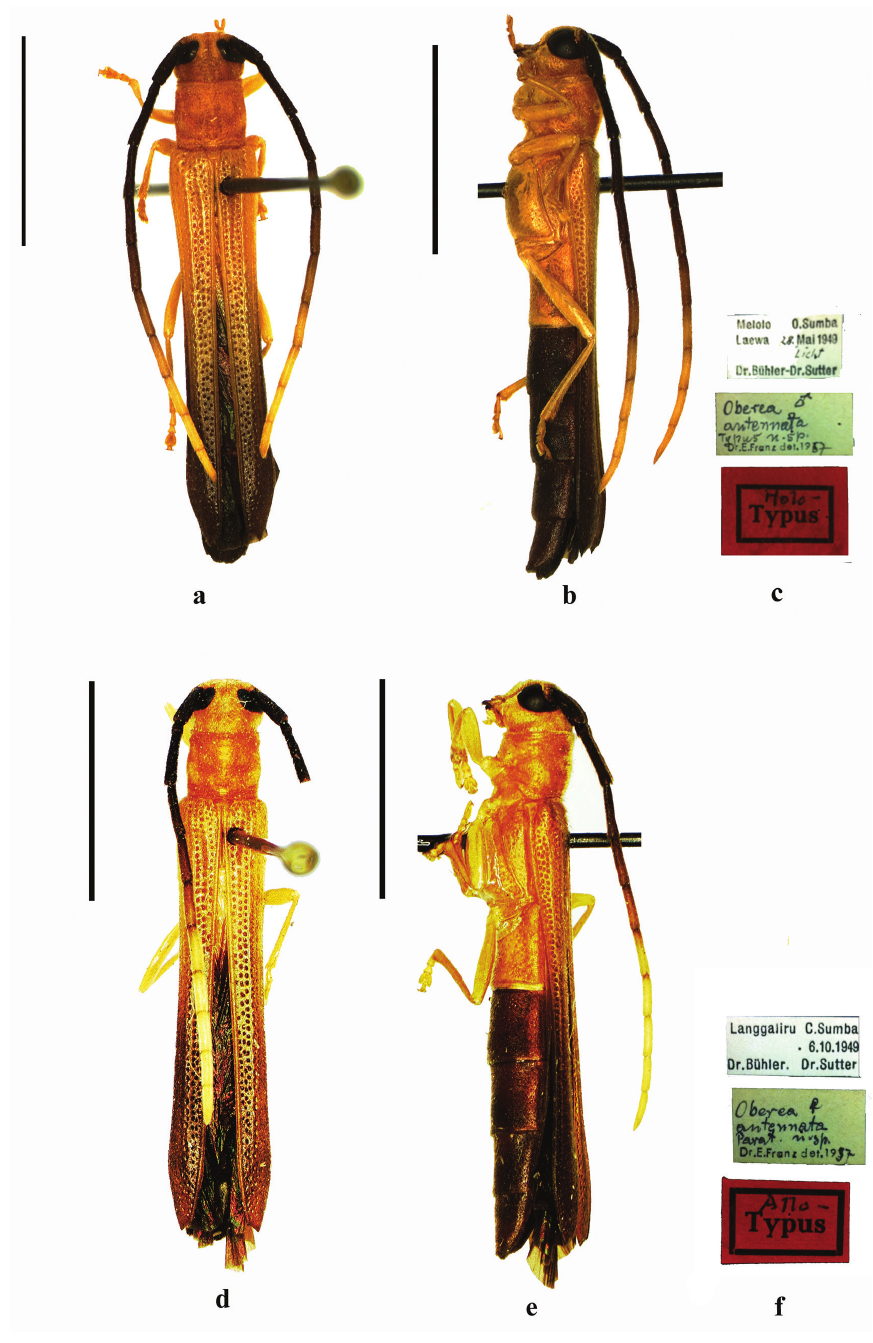
Figure 11. Habitus of O. antennata Franz, 1972, a–c holotype, male, from Sumba a dorsal view b lateral view, c label (not to scale) d–f allotype, female, from Sumba d dorsal view e lateral view f label (not to scale). Scale bar 5.0